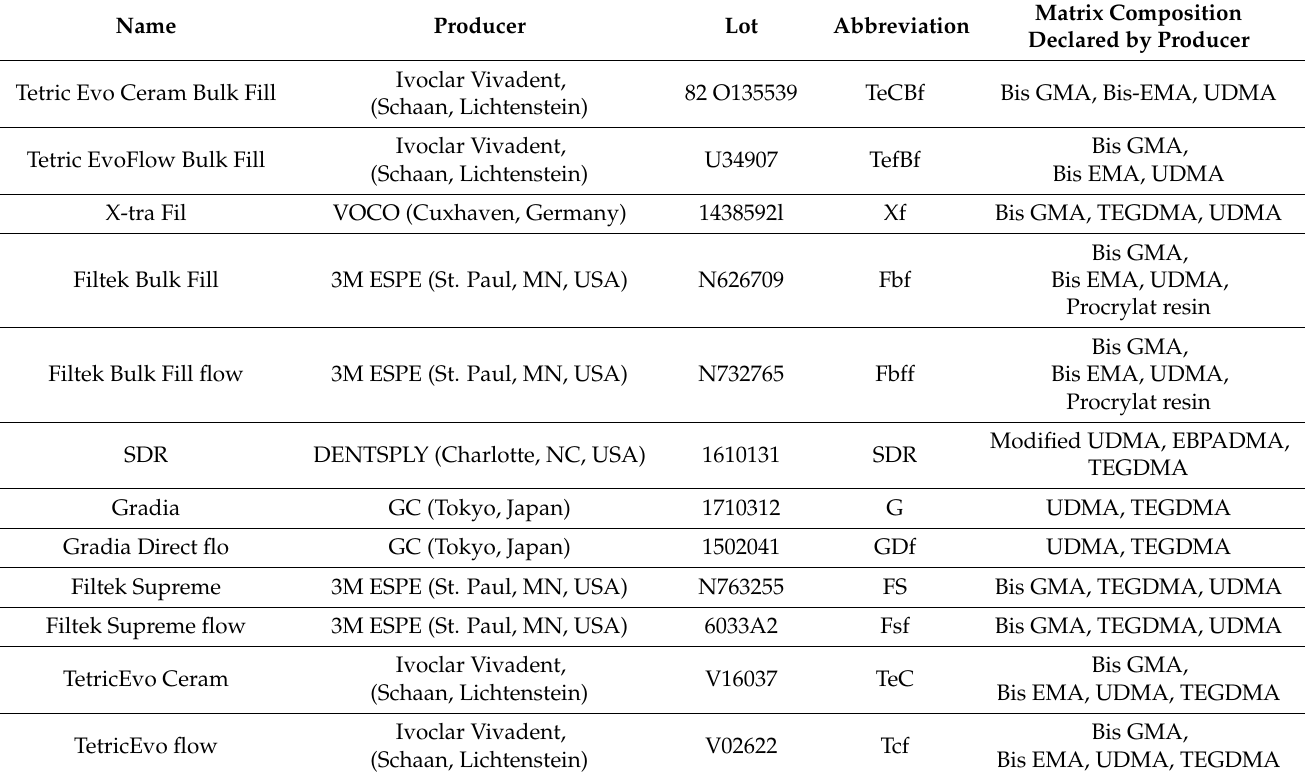
Table 1. Composite materials used in study.